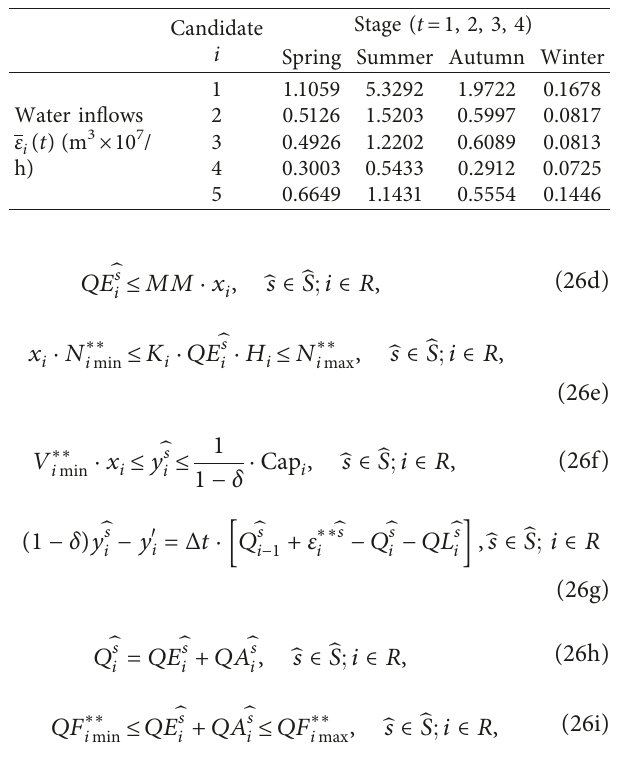
Table 6: Predicted water inflows in each seasonal